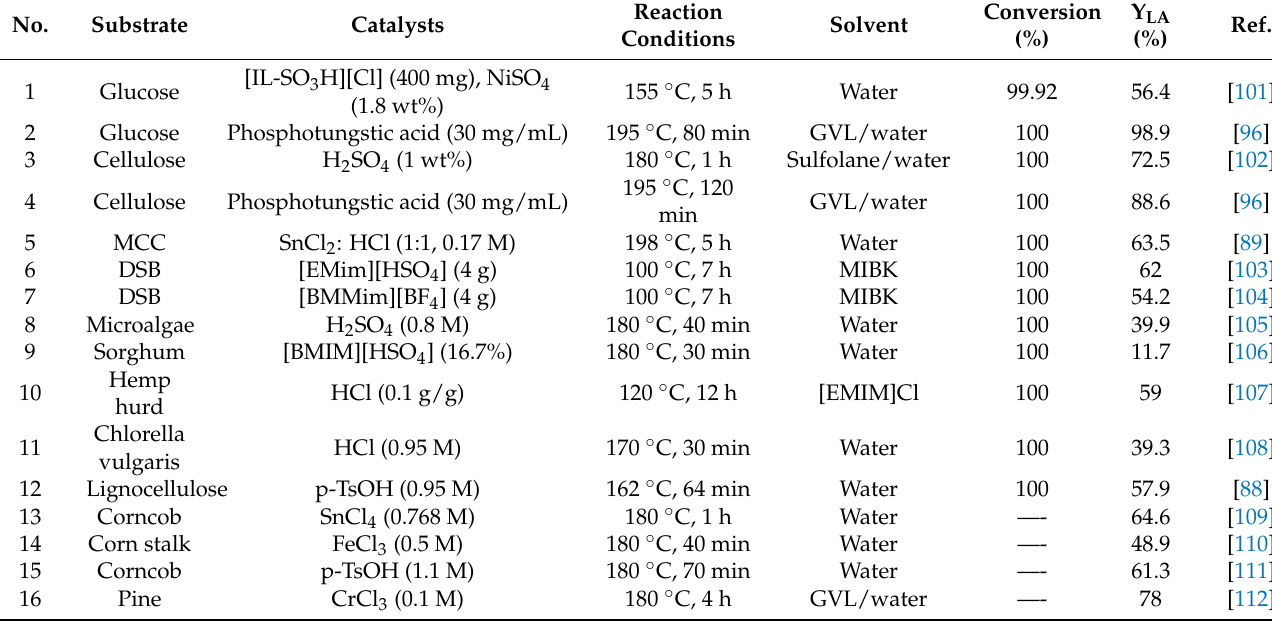
Table 3. Production of LA from lignocellulose and biomass over different homogeneous